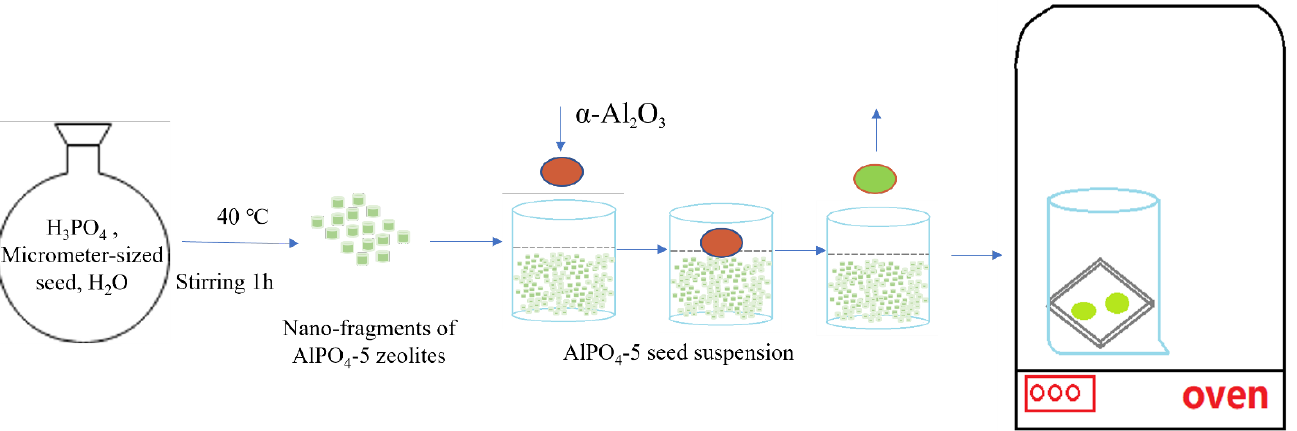
Figure 1. Schematic diagram of dip-coating method of AlPO 4 -5 seed layer on α -Al 2 O 3 support. Membrane1 (M1) was prepared using micron-sized crystals of AlPO 4 -5 as the seed from synthesized solutions of the molar composition: 1.0 Al 2 O 3 :1.3P 2 O 5 :1. 2TEA:400H 2 O. Using micron-sized crystals of AlPO 4 -5 as the seed, membrane2 (M2) was prepared in a mixture of H 2 O and mother liquor with a 3-to-1 ratio. For comparison, the hydrothermal synthesis was repeated, and membrane3 (M3) was obtained by etching AlPO 4 -5 ultra-small fragments as the seed from the molar composition of the synthetic solutions: 1.0